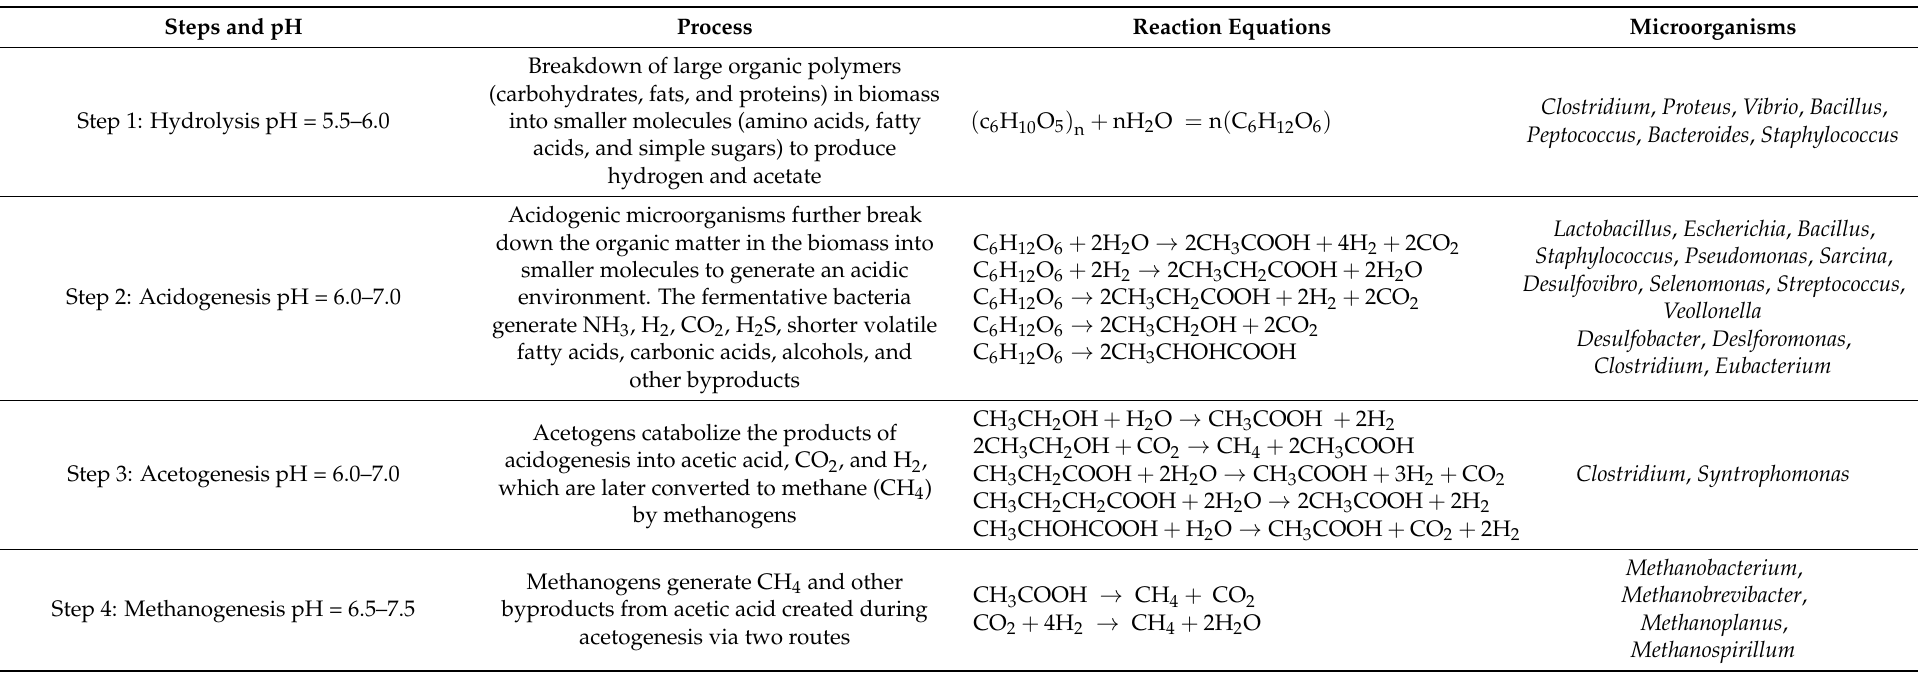
Table 12. Process reactions, pH, and microorganisms involved in anaerobic digestion. Adapted from [197,198]. Developed by the